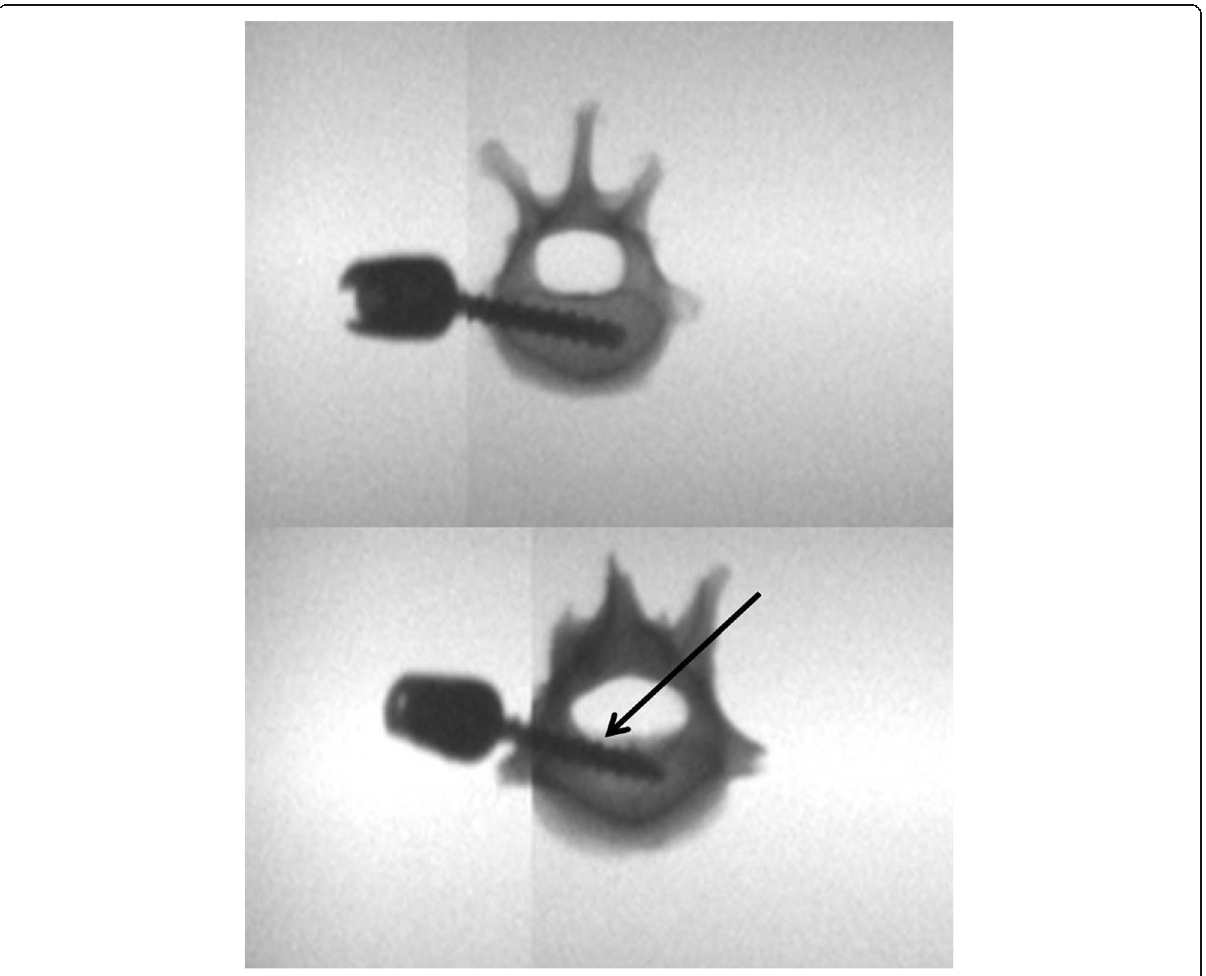
Fig. 1 X-ray image of specimen. The insertion position of the screw was checked by an X-ray image. Specimens were adapted for examination if the screw was in contact with cancellous bone only (upper image), and excluded as an inappropriate position if any part of the screw was in contact with cortical bone (the arrow in the lower